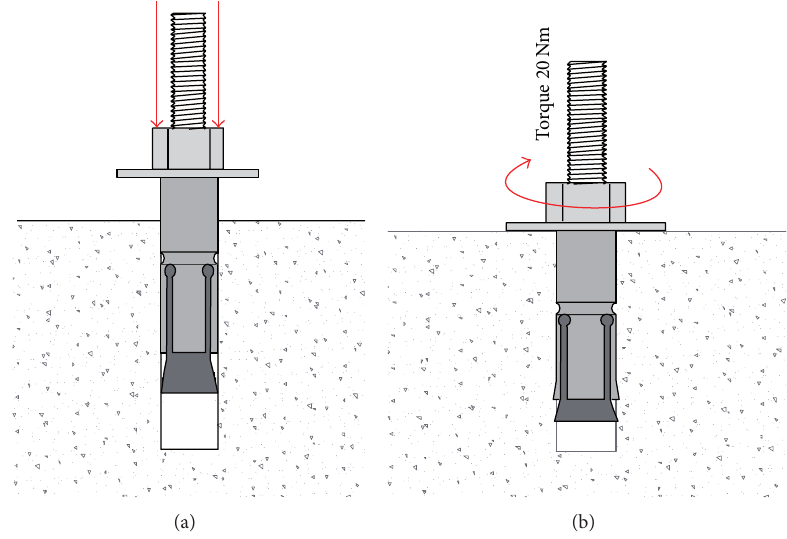
Figure 5: (a) Insertion of the split-sleeve by hammering the nut; (b) expansion by torque-controlled wrench.